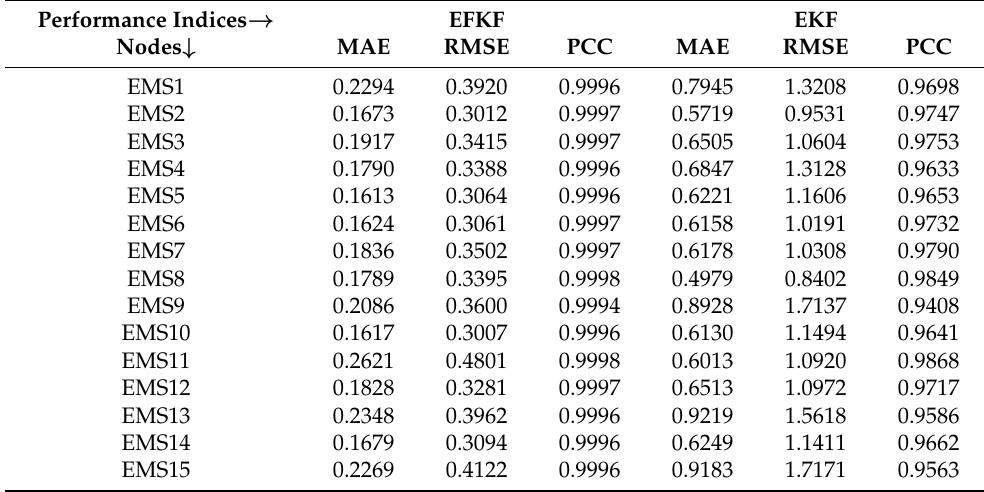
Table 4. Performance statistics of EFKF and EKF in dataset of PM1 during COVID-19